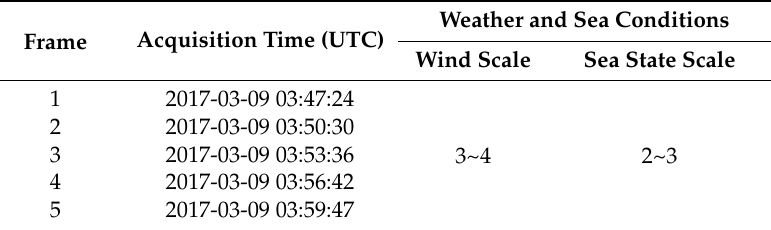
Figure 1. Two ships in five sequential images from the GF-4 satellite and detailed AIS information of ships. Table 1. Details of the GF-4 data sets.